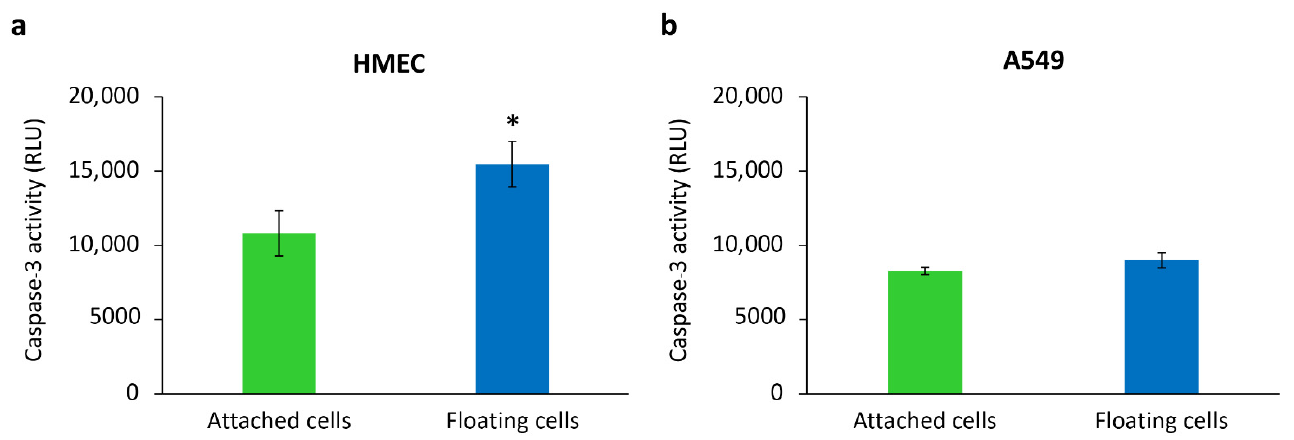
Figure 4. Caspase-3 activation in ( a ) human mammary epithelial cells/HMECs and ( b ) A549 cells after culturing under adherent condition (attached cells) and non-adherent condition (floating cells) for 24 h. Data are reported as mean ± SD from three independent experiments, * p < 0.05 compared to the attached cells.